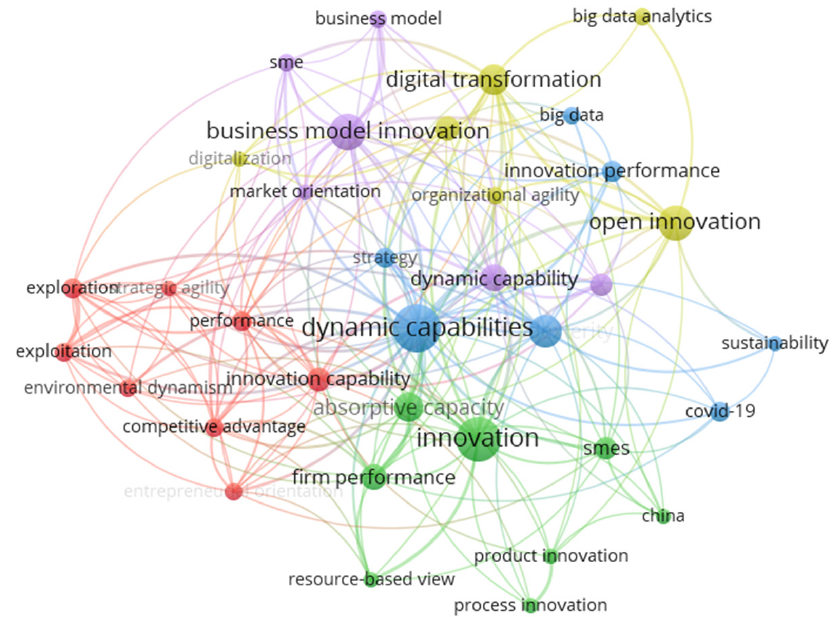
Figure 4. Network visualization—co-occurrence of author keywords. Source: Scopus/VOSviewer.